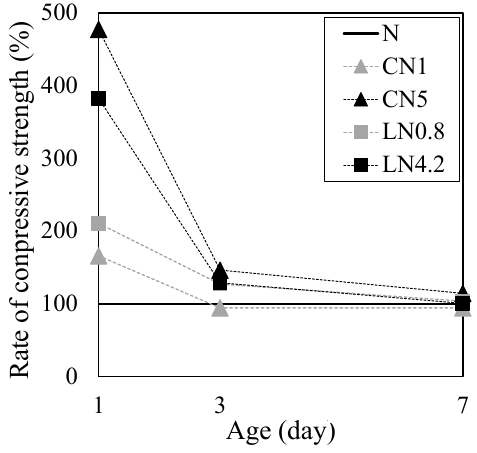
Figure 6. Change of compressive strength ratio of each age.